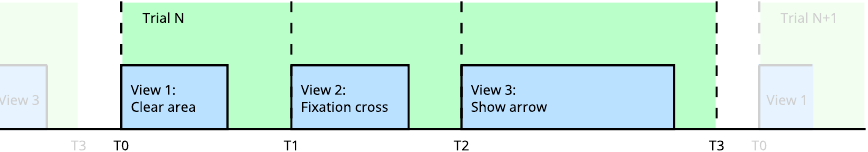
Figure 18. Stimuli delivery pipeline for MI paradigm. Each trial is composed of views; the pipeline features define the asynchronous execution of each view at the precise time.